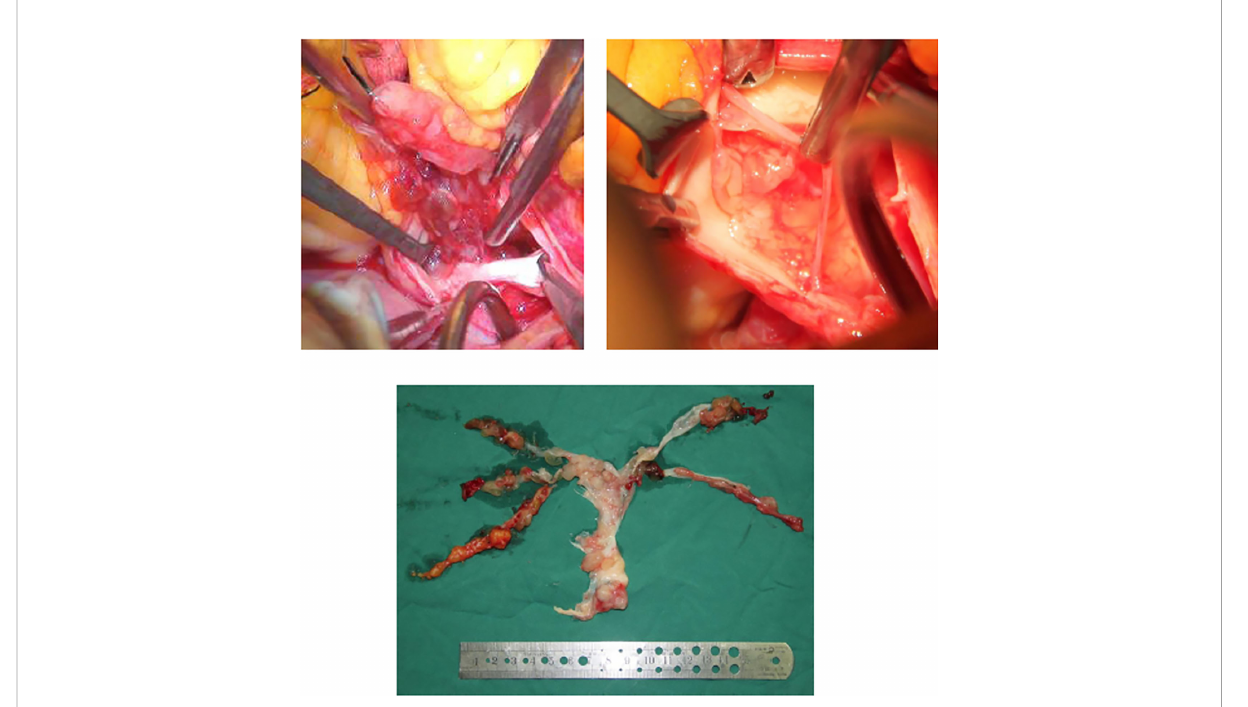
FIGURE 2 It is proved during operation that a huge, lobular mass originated in the pulmonary trunk, diffuse growth into both pulmonary arteries was observed, and the entire pulmonary endothelium was covered by a thin mucinous pellicle.